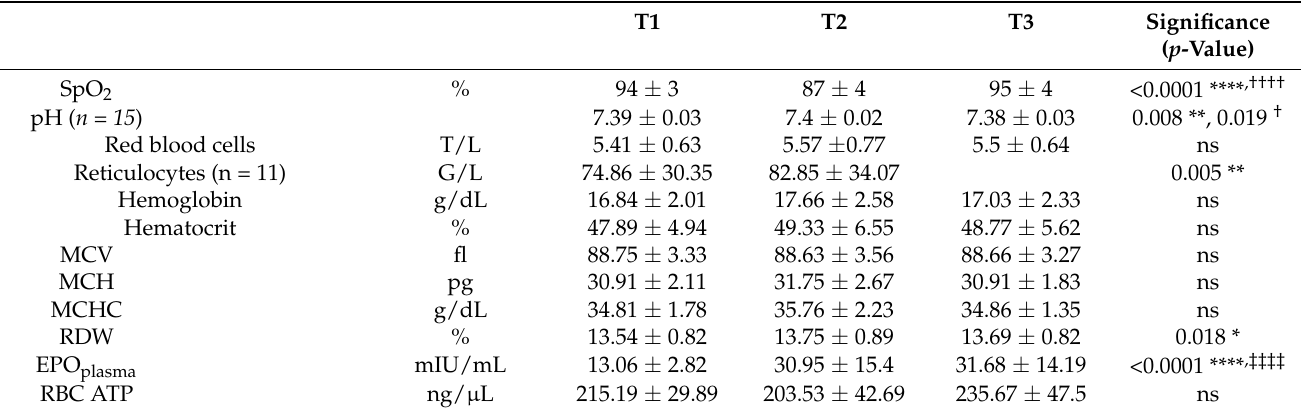
Table 2. SpO 2 and RBC parameters in normoxia (T1), after 24 h in hypoxia (T2), and 60 min after leaving the altitude room in normoxia